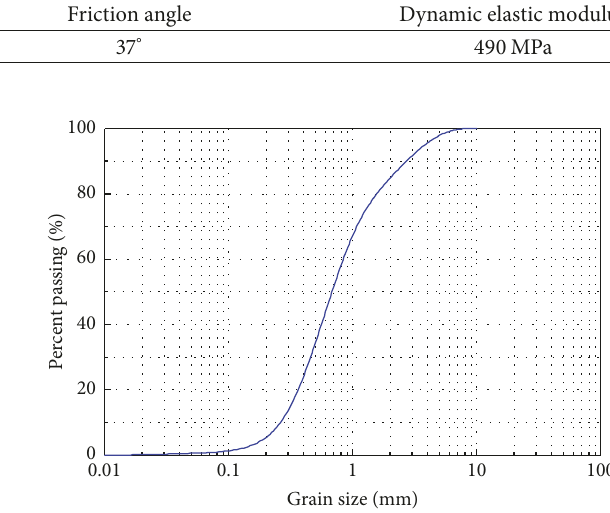
Figure 2: Grain size distribution of subgrade